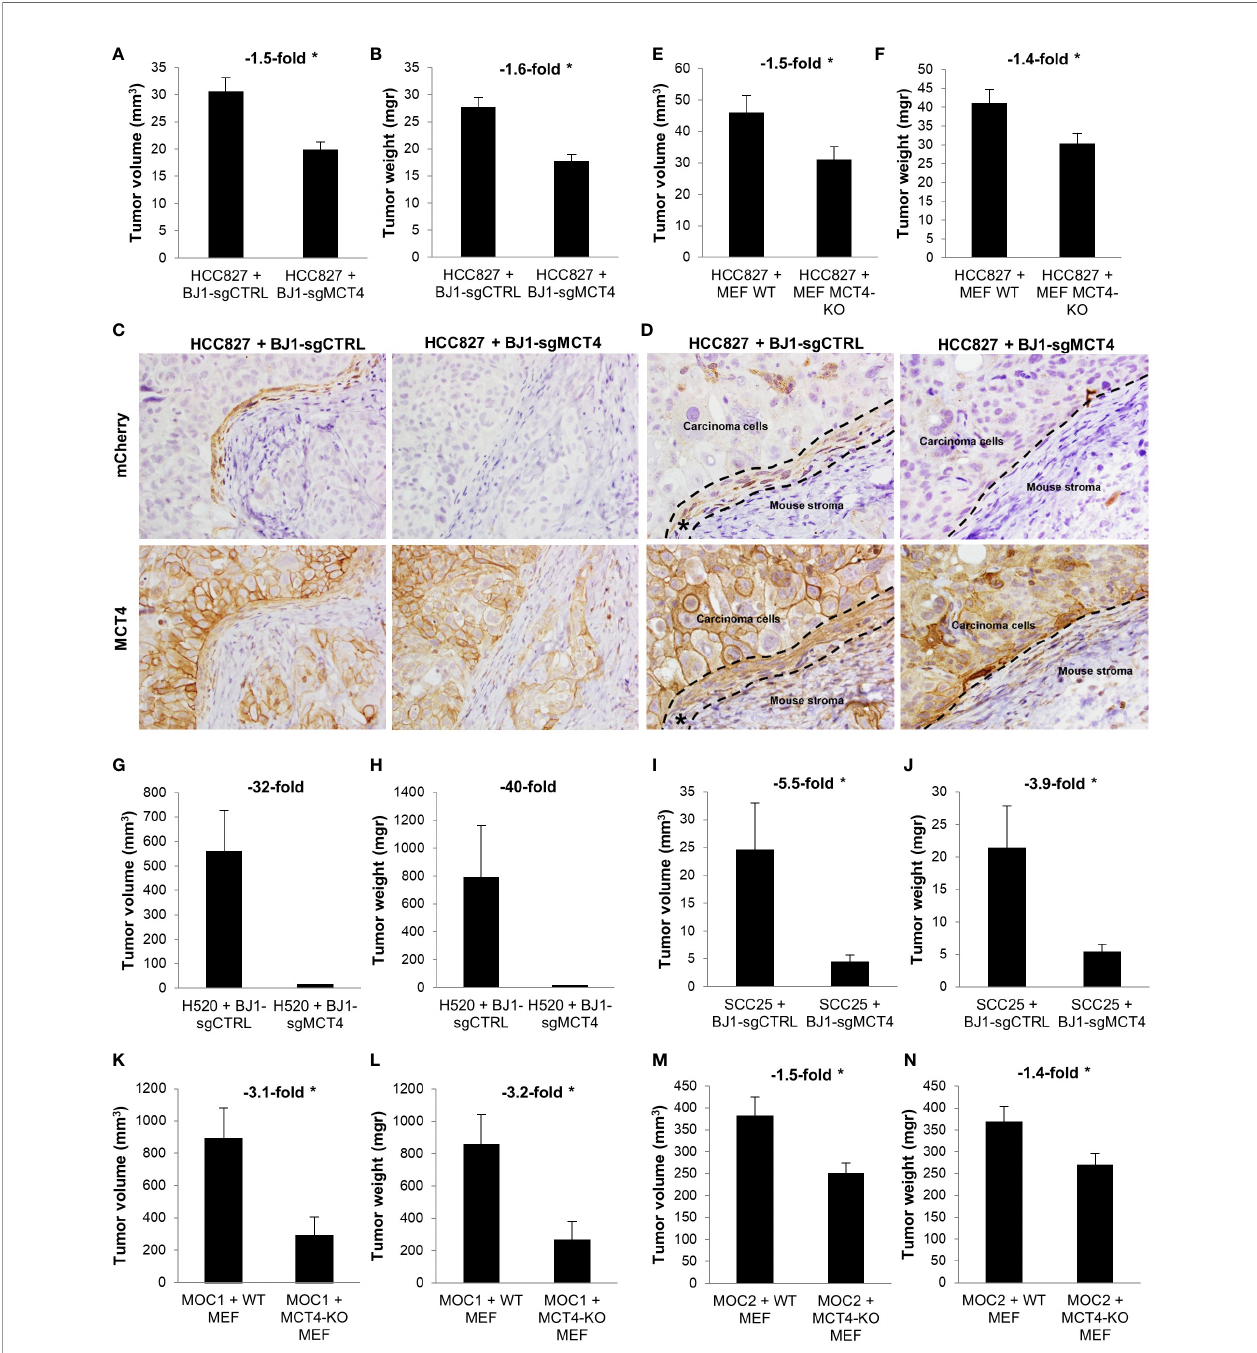
FIGURE 7 | Effects of fi broblast MCT4 on tumor growth. (A – J) Tumor xenografts were generated by co-injecting human ADT carcinoma cells with fi broblasts expressing or lacking MCT4 into nude mice. (A) Tumor volume and (B) tumor weight of HCC827 + BJ1-sgCTRL/sgMCT4 xenografts harvested at 2.5 weeks post-implantation. (C, D) Immunohistochemical assessment of mCherry (to detect BJ1) and MCT4 expression in HCC827 + BJ1-sgCTRL/sgMCT4 tumors, and image acquisition at 40x (C) and 60x (D) . In panel (D) the area of carcinoma cells, mouse stroma, and injected mCherry-expressing BJ1 (*) are marked. (E) Tumor volume and (F) tumor weight of HCC827 + WT/MCT4-KO MEF xenografts harvested at 4 weeks post-implantation. (G) Tumor volume and (H) tumor weight of H520 + BJ1-sgCTRL/sgMCT4 xenografts harvested at 2 months post-implantation. (I) Tumor volume and (J) tumor weight of SCC25 + BJ1-sgCTRL/sgMCT4 xenografts harvested at 6 weeks post-implantation. (K – N) Syngeneic tumors were generated by co-injecting C57BL/6 carcinoma cells with WT or MCT4-KO MEFs into WT or MCT4-KO C57BL/6 mice. (K) Tumor volume and (L) tumor weight of MOC1 + WT/MCT4-KO MEF tumors harvested at 7 weeks post-implantation. (M) Tumor volume and (N) tumor weight of MOC2 + WT/MCT4-KO MEF tumors harvested at 3 weeks post-implantation. Student ’ s t-test was used for statistical analyses (*p<0.05). (a.u., arbitrary